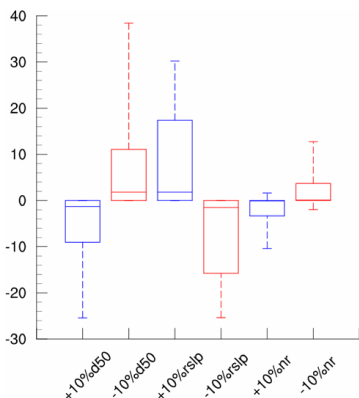
Figure 12. Boxplot of the changes in total suspended load when changing the